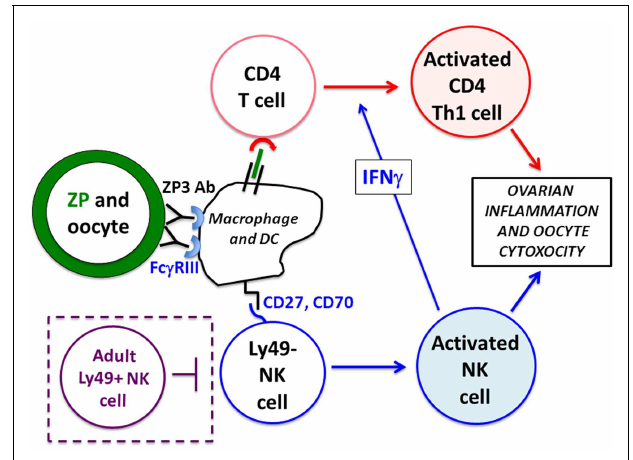
FIGURE 2 | Mechanism of nAOD induction . Ovarian ZP3 immune complexes on the zona pellucida (ZP, green) are formed after maternal autoAb transfer and stimulate Fc γ RIII + macrophage/dendritic cells that activate (1) a de novo CD4 + T cell response (in red), and (2) Ly49-negative neonatal NK cells (in blue).These NK cells produce IFN γ promoting aTh1 pathogenic CD4 + T cell response to ovarian antigens. Ovarian inflammation and oocyte depletion is, in turn, mediated by the Fc γ RIII + neonatal NK cells and activatedTh1 effector CD4 + T cells. Mice older than 9days fail to develop nAOD because of the emergence of Ly49 + NK cells (in purple dotted box) andTreg function (not